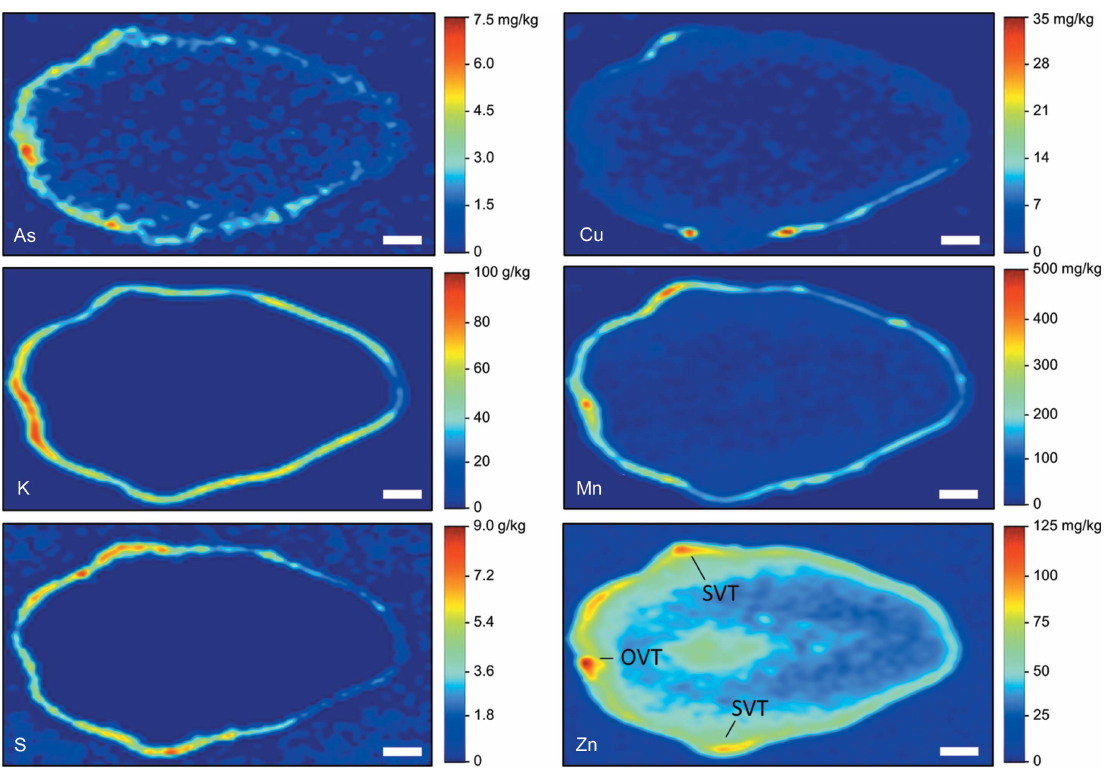
Figure 3 Quantitative SR- m XRF elemental concentrations in the cross-section of a rice grain grown in soil with low levels of As ( (cid:3) 5 mg kg (cid:2) 1 ). Scale bar denotes